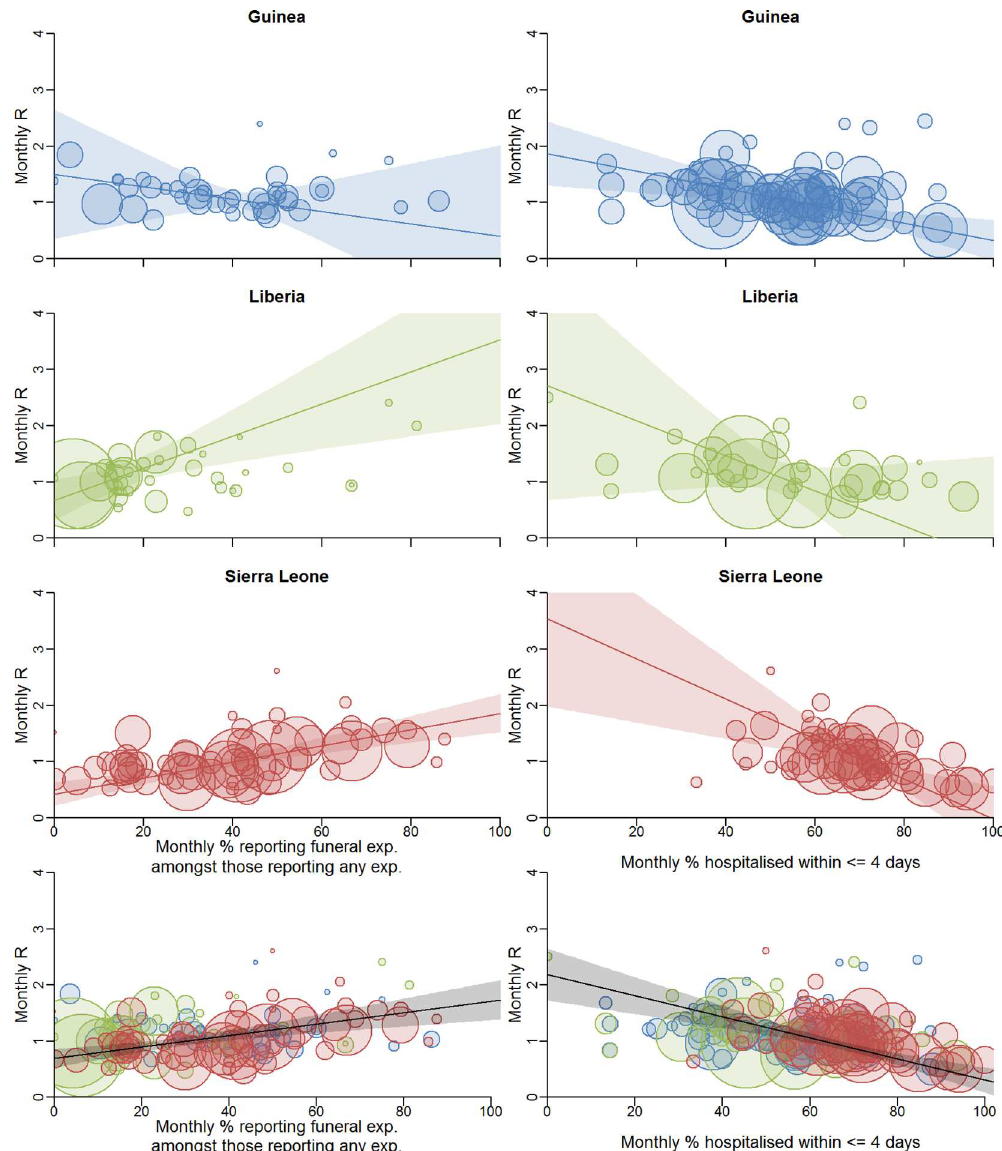
Fig 4. Correlation between local transmission intensity and local population measuresof presumed heightened risk of infection. Correlationbetweenlocal transmissionintensity and proportionof cases reporting funeral exposures amongthose reportingany exposure (left) and proportionof cases hospitalised within (cid:20) 4 days of symptom onset among those hospitalised (right). The scatter plots show these monthly proportions againstmonthly estimated reproduction numbers R (method as previous[11]) for the supplemented incidence(i.e., incidencebased on two data sources includingthe line-list, see [12]). Each point is a district-month. Trend lines are shown with 95% confidenceintervals(shadedareas). We use a weightedregressionmethod that takes account of the uncertainties in the data [20]. The area of each circle is proportional to the weight of that point (see section 1.7 in S1 Text). In the bottom row, the black trend line is for the whole dataset. See Figures j and l and Table d in S1 Text for details, includingtrend line parameters. exp., exposure.